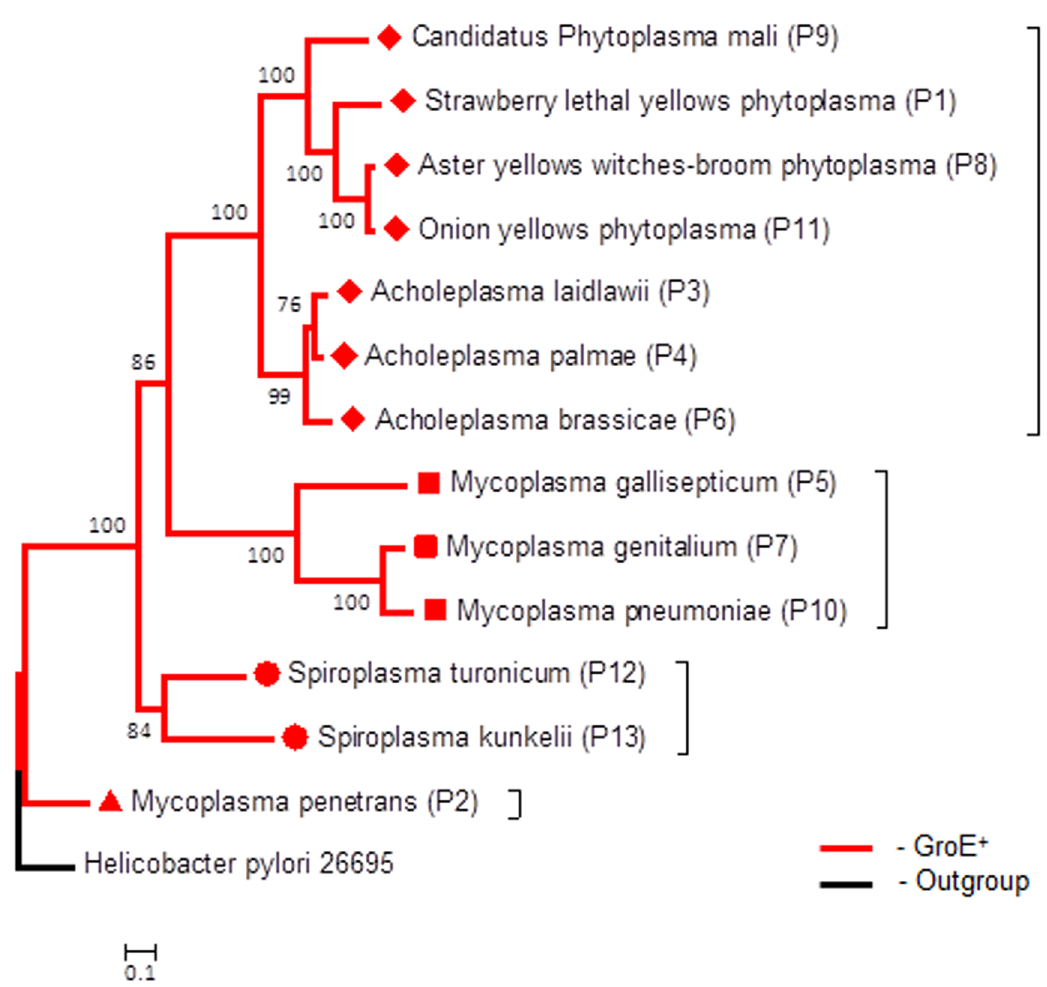
Fig 3. Evolutionary tree of GroEL sequences of GroE + mollicutes. The diamonds and squares show the two major clades that contain the GroE system. The triangle marks the species where lateral gene transfer (LGT) was suggested before and circles mark the two additional species for which we suggest LGT